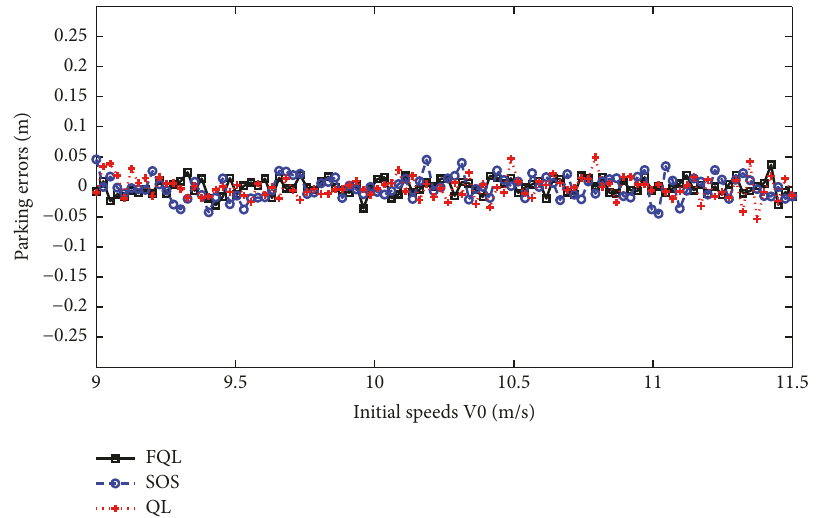
Figure 8: Each parking error after 50 trials about different initial speeds.